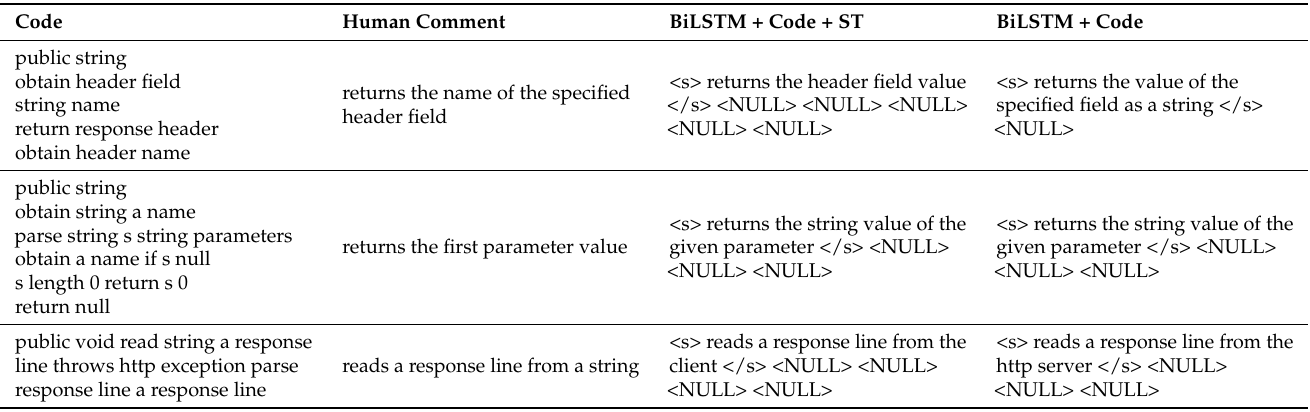
Table 2. Examples of generated code